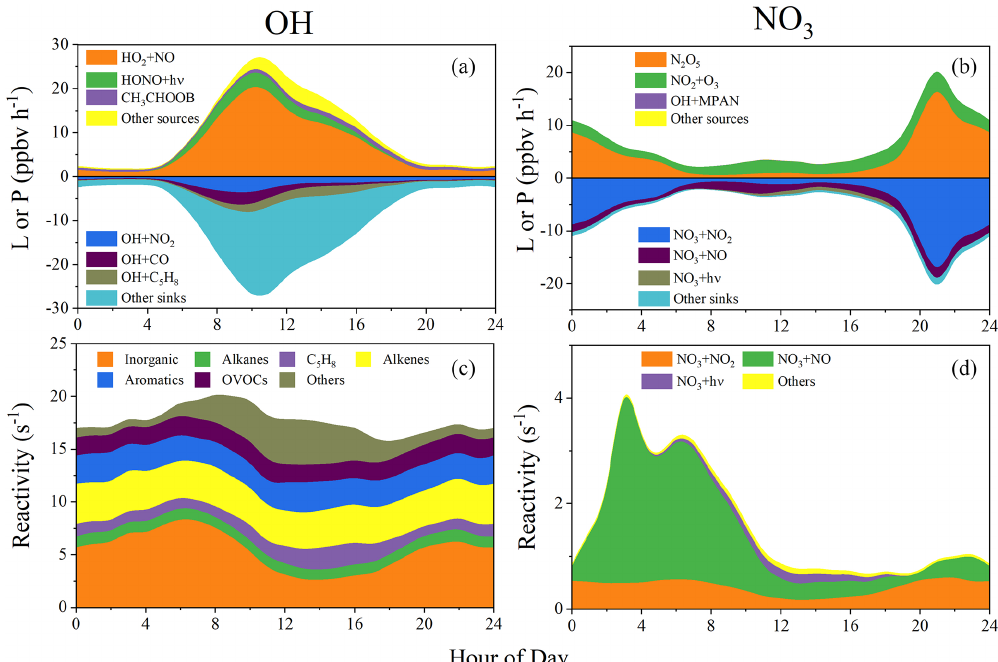
Figure 11. Production rates ( P ), loss rates ( L ), and reactivities of radicals. (a) L and P of OH. (b) L and P of NO 3 . (c) Reactivities of OH. (d) Reactivities of NO 3 . In (a) and (b) , the top three sources or sinks are shown, and all the others are summarized as “Other sources” or “Other sinks”. In (c) , OH reactivities with different families of the measured species are shown, and reactivities with all the unmeasured species are summarized as “Others”. In (d) , NO 3 reactivities from the top three reactions are shown, and all the others are summarized as